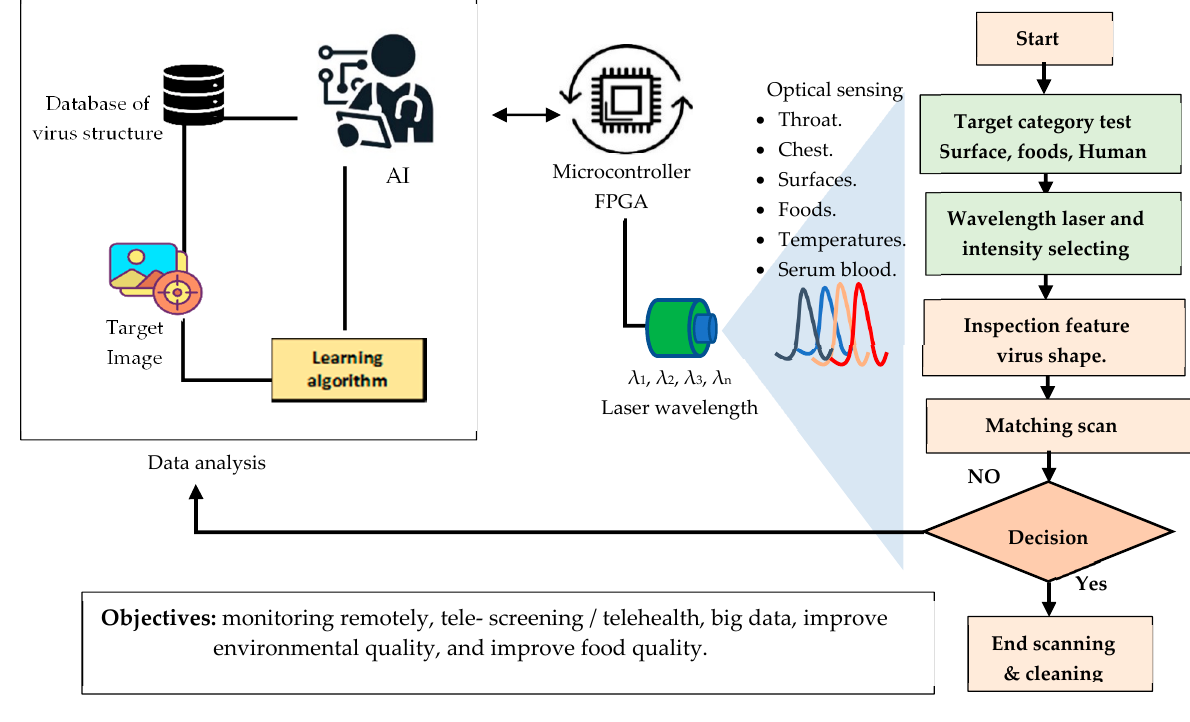
Figure 5. Framework illustrating detection of COVID-19 in the